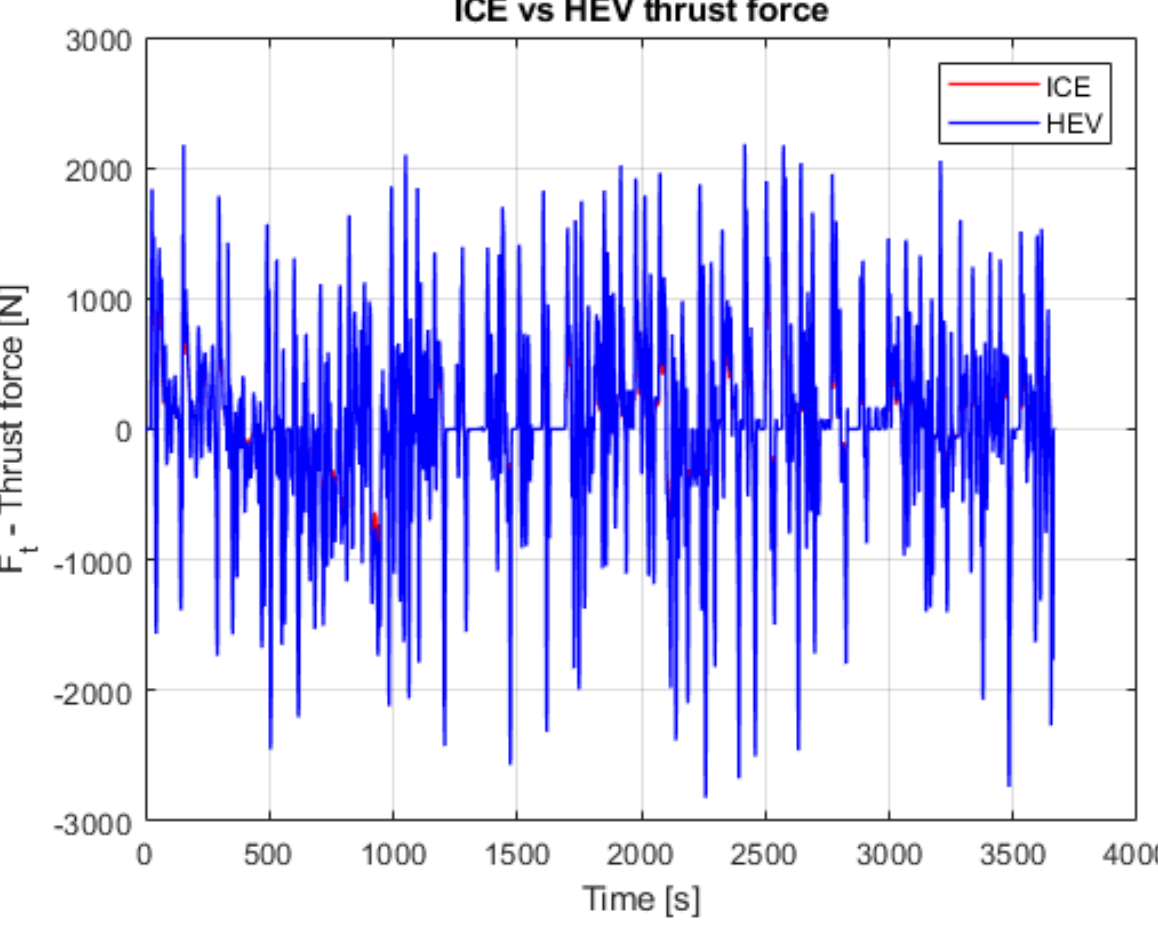
Figure 11. Thrust force comparison between ICE vehicle model and HEV model.